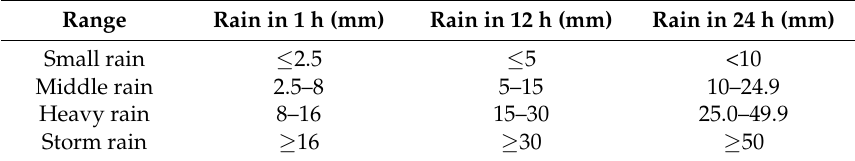
Figure 8. Modeled soil water content following each measured precipitation time-series during the forecast period. The variations of water content after precipitation were much more sensitive than the field measurement data in Figure 4, especially at 5 cm.